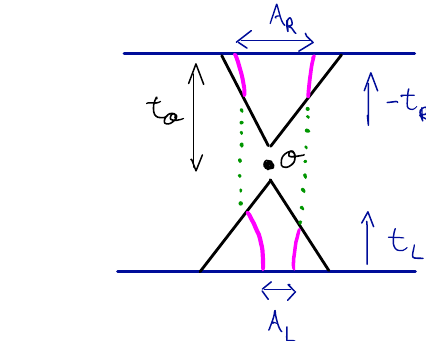
( t O ; 0). The solid portions of the O by t scr O